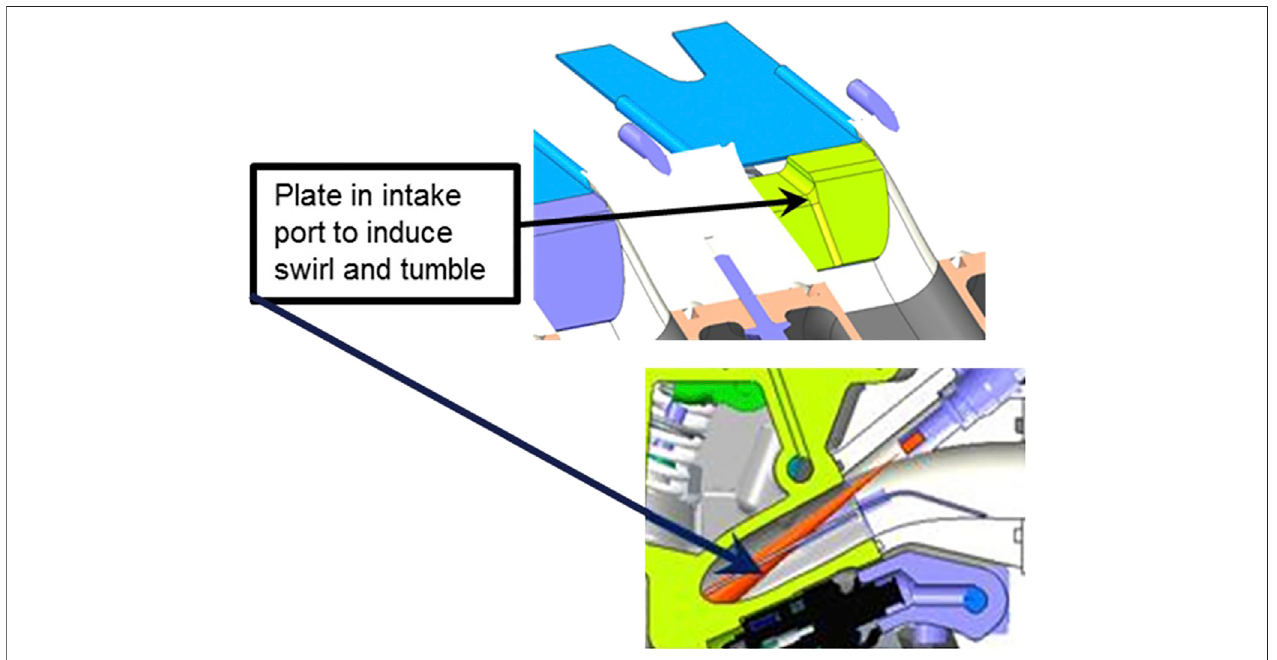
FIGURE 4 | Illustration of tumble plate insert in 1.5 L jet ignition